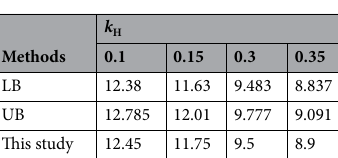
Table 3. The influence of k H on N sc = P su /( γB